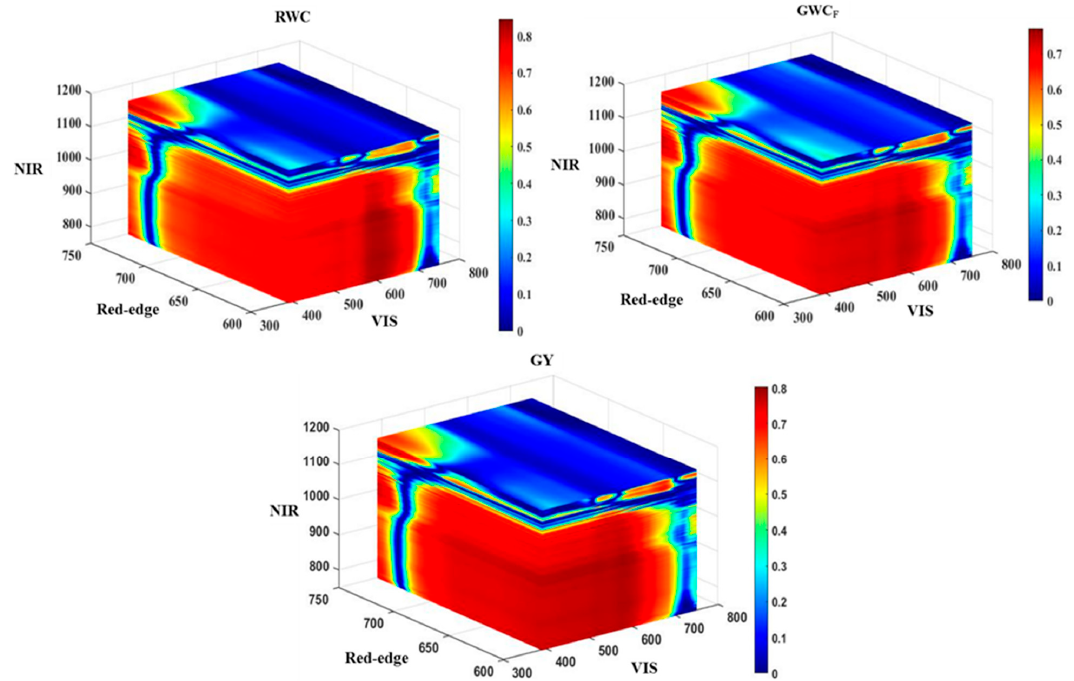
Figure 4. Three-dimensional (3-D) correlogram maps showing the coefficients of determination (R2) between all the possible three-band combinations in the VIS (400–700 nm), red-edge (680–780 nm), and NIR (700–1148 nm) and the relative water content (RLWC), gravimetric water content on a fresh weight basis (GWC F ), and grain yield (GY) using the pooled data of wheat cultivars, seasons, irrigation regimes, and replications.